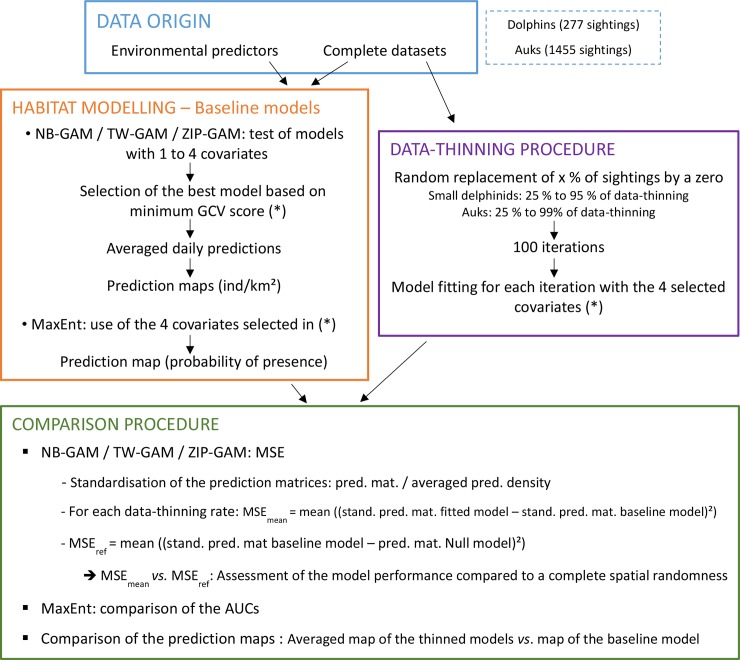
Flowchart of the methods used in the study.NB-GAM: generalised additive model with a negative binomial distribution; TW-GAM: generalised additive model with a Tweedie distribution; ZIP-GAM: generalised additive model with a zero-inflated Poisson distribution; MaxEnt: maximum entropy model; GCV: generalised cross-validation; ind: individuals; MSE: mean squared error; stand.: standardised; pred.: prediction; mat.: matrix; ref: reference; AUC: area under the curve.